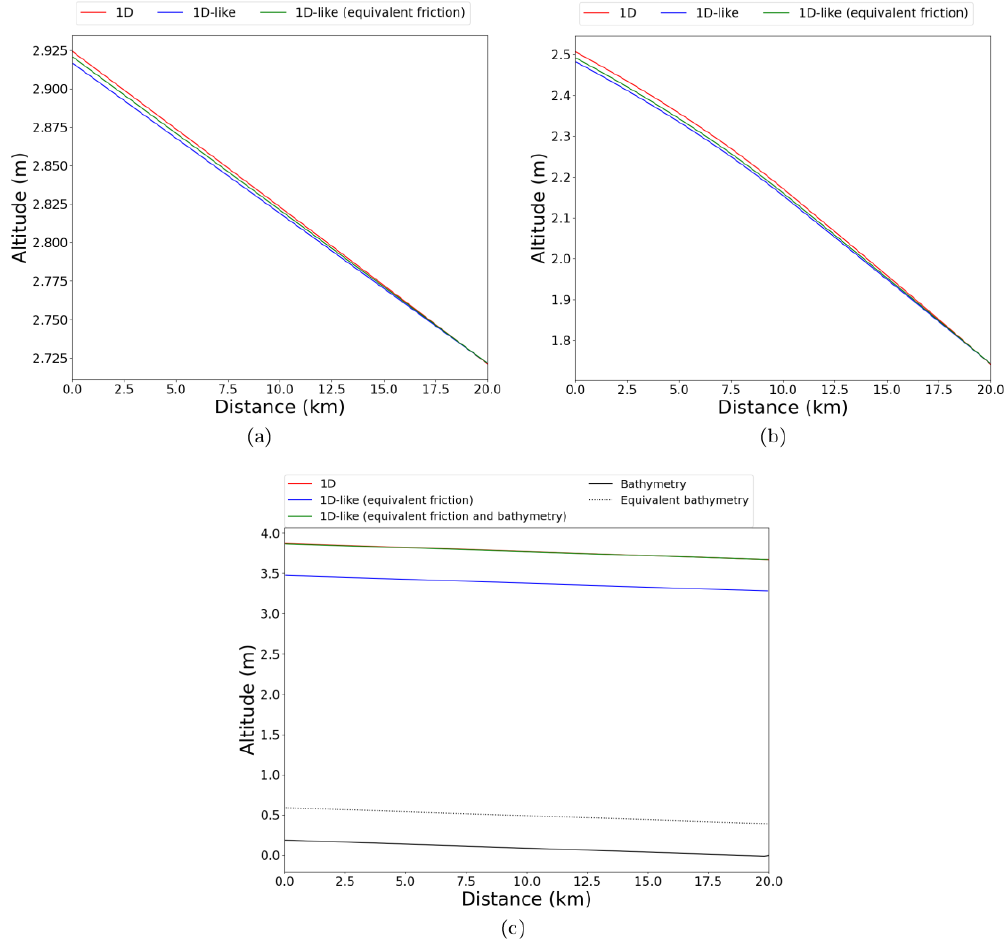
Figure 8. Effective friction analysis for steady waterline in academic cases: (a) rectangular channel with constant slope, (b) rectangular channel with slope break, (c) parabolic channel with constant slope. Values of effective friction parameter α (cid:2) sm − 1 / 3 (cid:3) : (a) 5 . 06 × 10 − 2 , (b) (cid:0) 5 . 06 × 10 − 2 , 5 . 04 × 10 − 2 (cid:1) , (c) 5 . 46 × 10 − 2 . Bathymetric shift δ b [m]: (a) 0, (b) 0, (c) 0 . 591. One-dimensional reference model: fixed time step 5s, spatial step 100m. Average Courant number equals 0 . 26 1D-like models: adaptive time step with mean value of 9s. One- dimensional-like cell length 100m; average Courant number equals 0 .